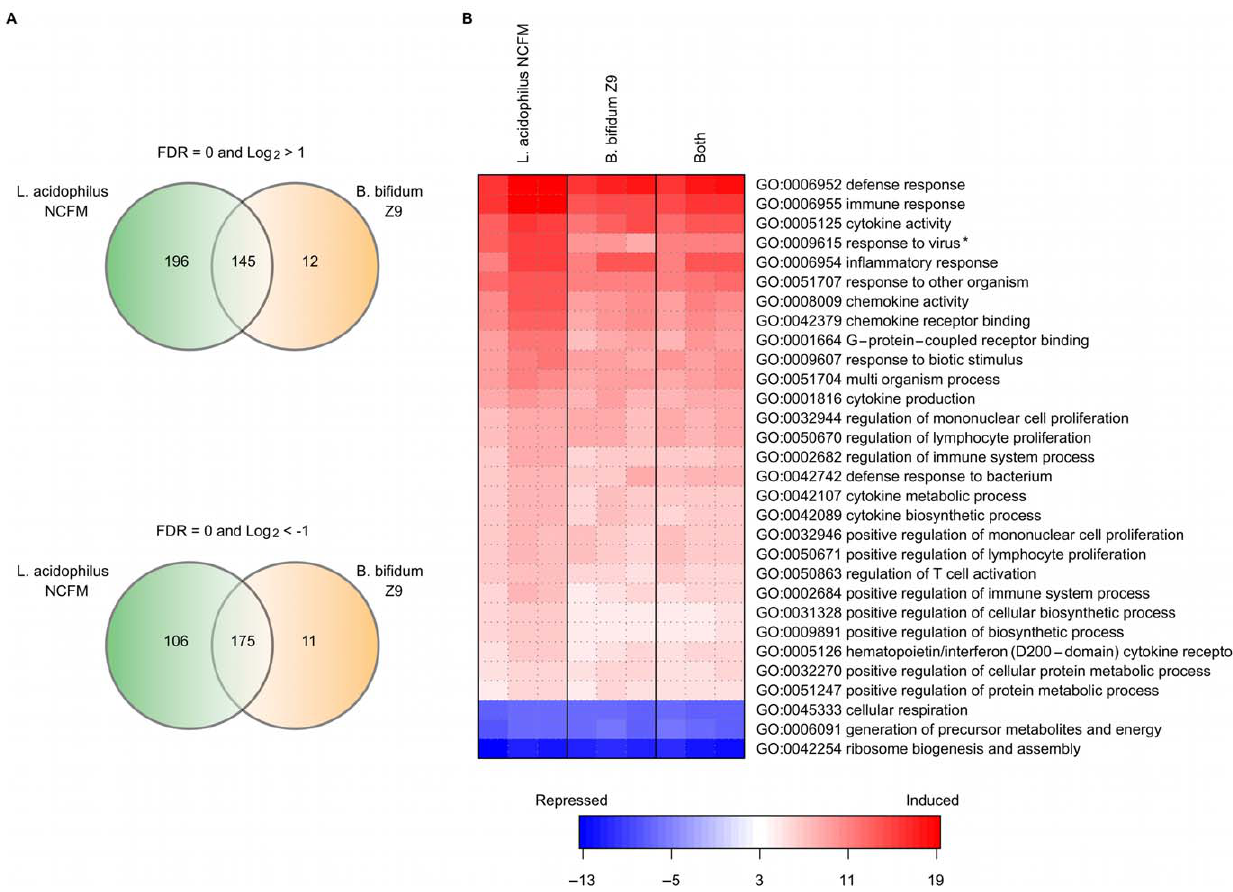
Figure 2. Microarray analysis of dendritic cells stimulated with Lactobacillusacidophilus NCFM and Bifidobacteriumbifidum Z9. Up- and downregulation of genes upon incubation of dendritic cells with L. acidophilus NCFM and B. bifidum Z9, respectively, and both strains in combination. A. Venn diagram depicting the distinct up- and down regulation and overlap of genes. Only genes with an absolute fold change greater than 2 were included. B. Parametric Gene Set Enrichment of Gene Ontology (GO) Biological Process terms of the top 30 most significant GO terms comparing L. acidophilus NCFM vs. control (no stimulation). Blue indicates repression of the genes, white indicates no change and red indicates induction of the genes in the GO term. Only the GO term ‘‘response to virus’’ was significantly different (*) when comparing L. acidophilus NCFM and B. bifidum Z9 responses.